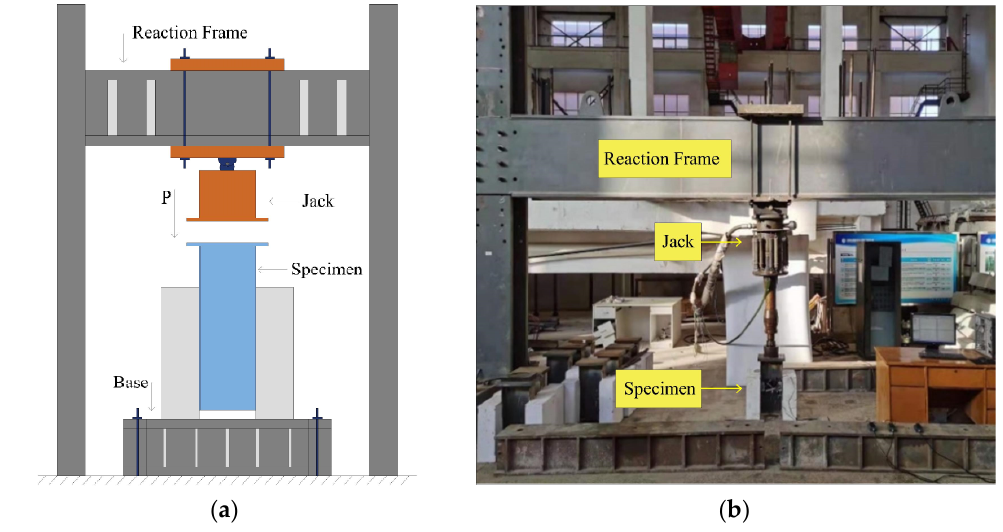
Figure 3. Test loading: ( a ) loading schematic; ( b ) site photo.